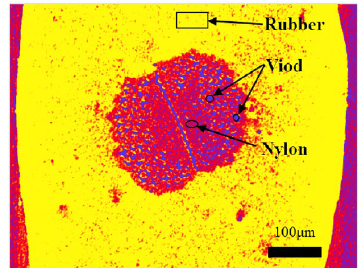
Figure 15. The division diagram of nylon-rubber-void (the surrounding yellow areas are rubber, red areas are nylon, and purple areas are pores).